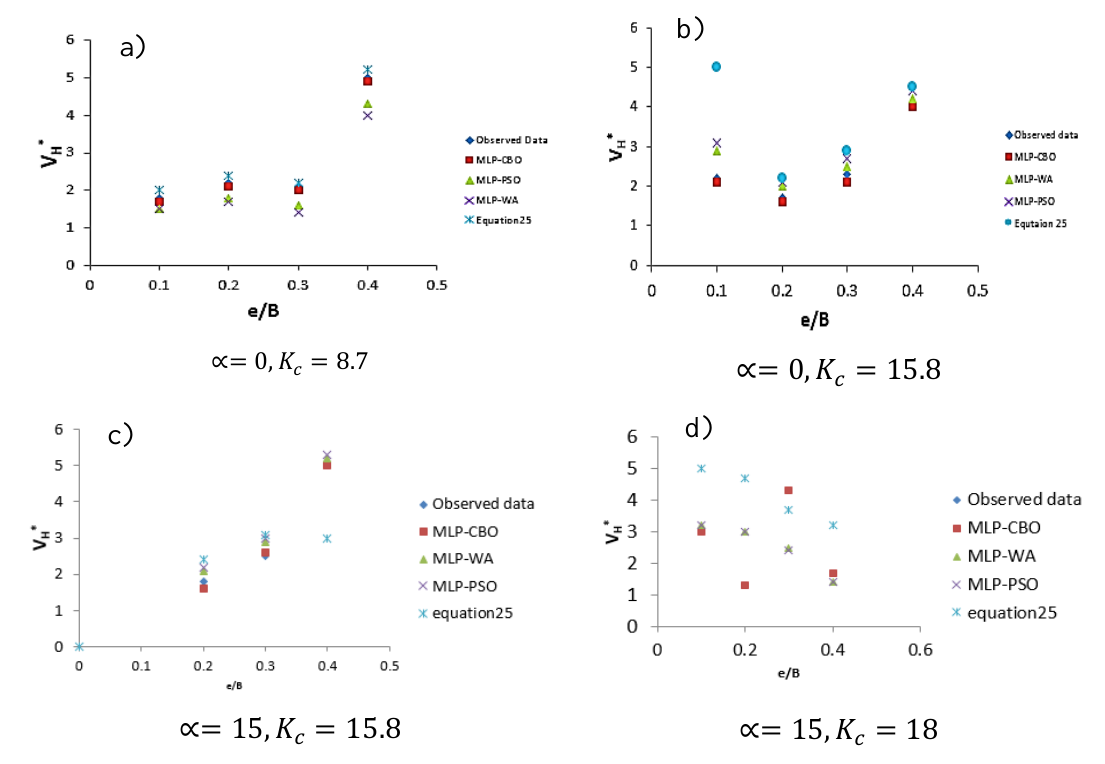
Figure 10. The variation of parameters versus scour rates. ( a ) ∝= 0, 𝐾 𝑐 = 8.7 ; ( b ) ∝= 0,𝐾 𝑐 = 15.8 ; ( c ) ∝= 15, 𝐾 𝑐 = 15.8 ; ( d ) ∝= 15, 𝐾 𝑐 = 18 .